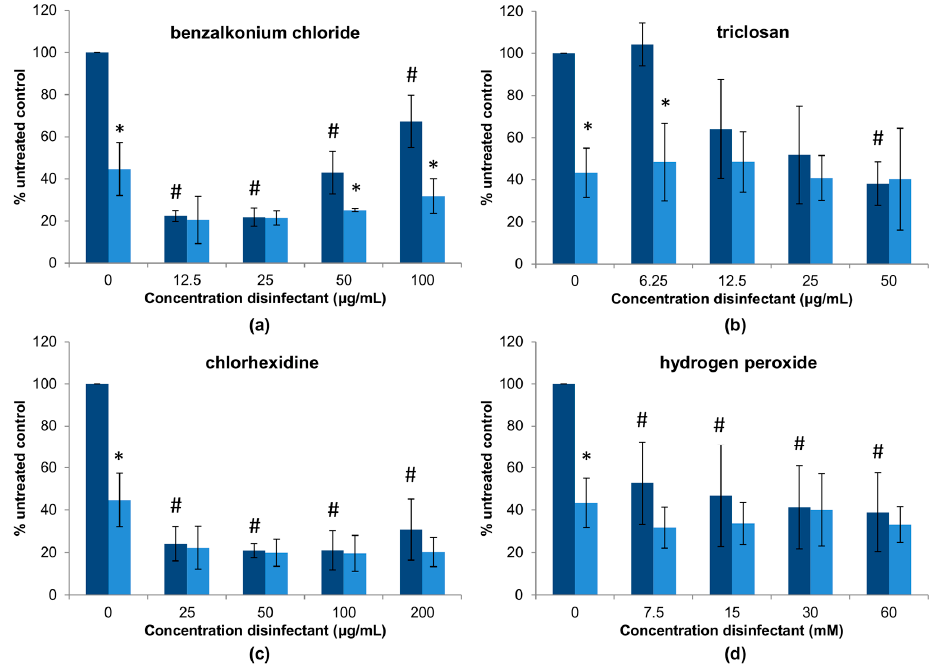
Figure 3. Representation of the data obtained in the biofilm removal assays to test the interactions between a high dose of phage phiIPLA-RODI (10 9 PFU/mL) and different concentrations of the following disinfectants: ( a ) benzalkonium chloride; ( b ) triclosan; ( c ) chlorhexidine; ( d ) hydrogen peroxide. Dark blue and light blue bars represent samples without or with phage treatment. Values obtained without phage treatment were compared to those treated with phiIPLA-RODI and p -values < 0.05 were considered significant (*). Additionally, values obtained with disinfectant were compared to the untreated control to determine the antibiofilm effects of the four antimicrobials and p -values < 0.05 were considered significant